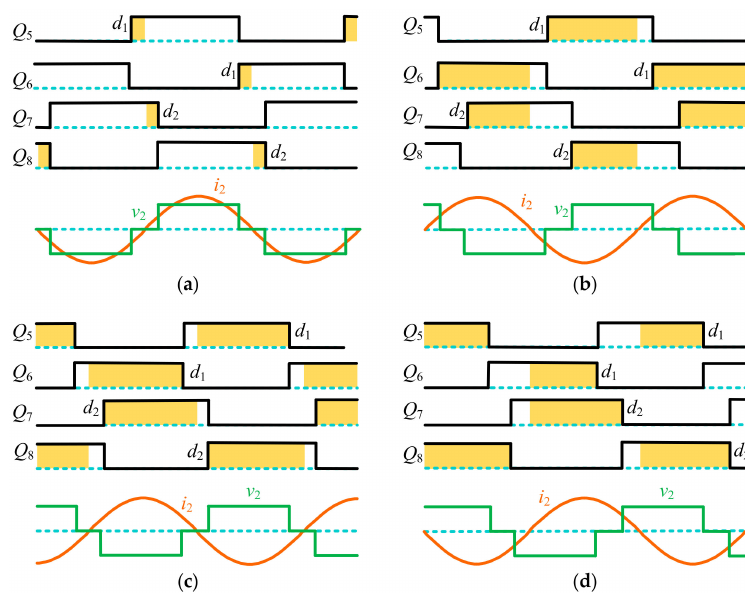
Figure 7. Dead-time elimination regions in the DAB WPT system where the driving signal in the shadow areas can be turned off. ( a ) Region 1; ( b ) Region 2; ( c ) Region 3; ( d ) Region